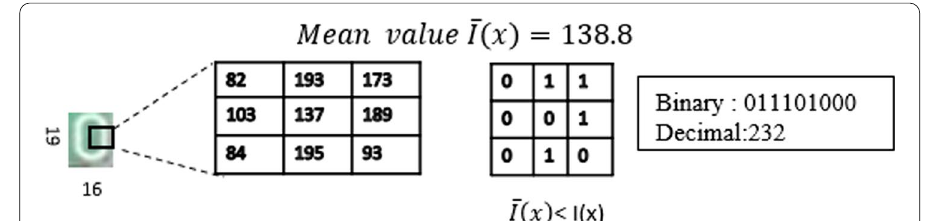
Fig. 8 The MCT feature extraction